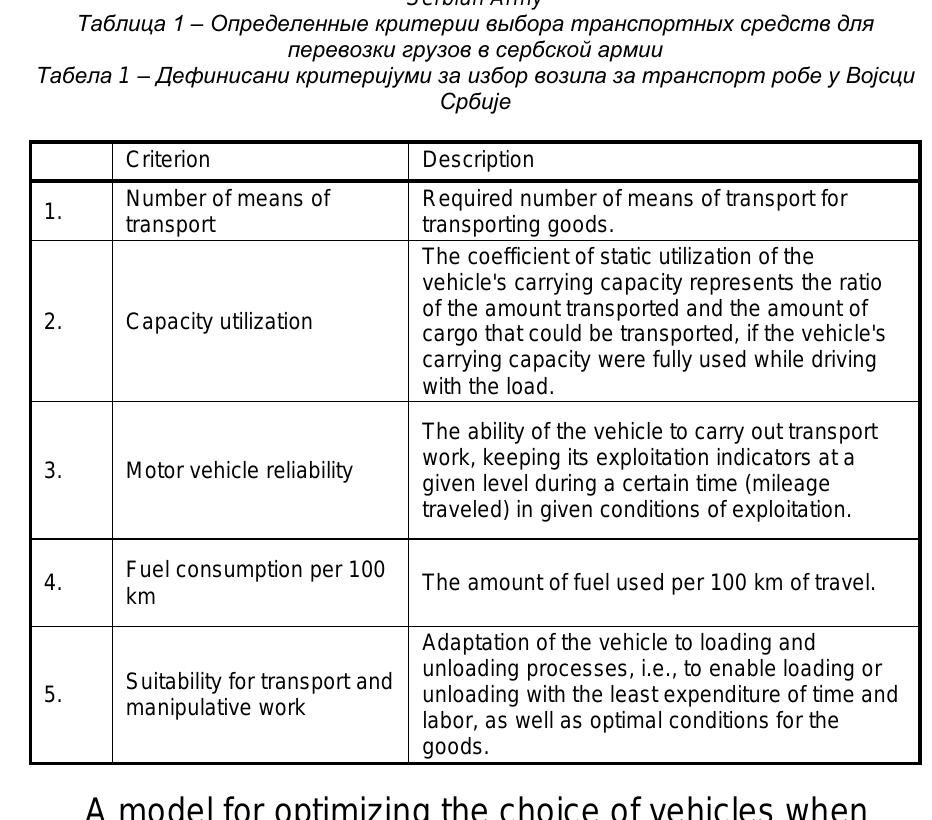
Table 1 – Defined criteria for the selection of vehicles for the transport of goods in